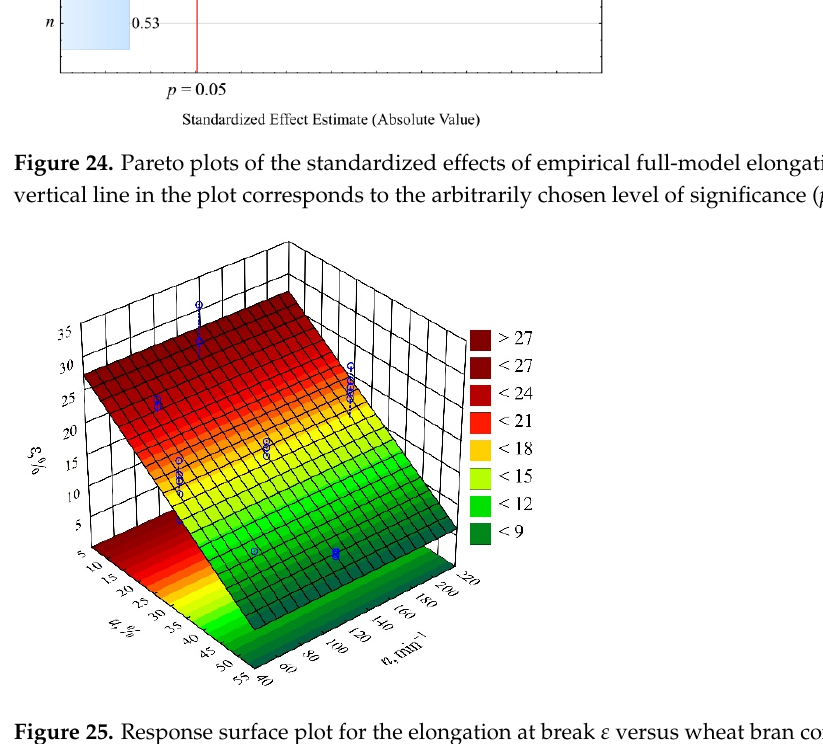
Figure 25. Response surface plot for the elongation at break ε versus wheat bran content u and screw speed n.